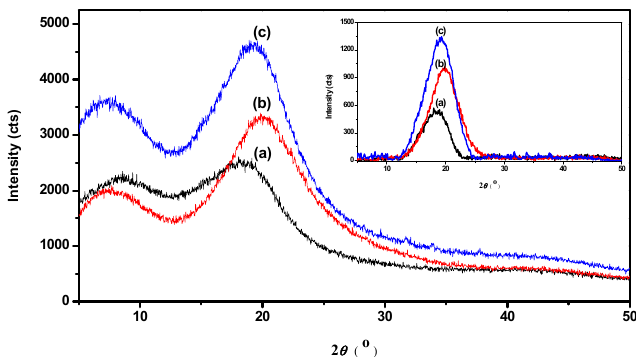
Figure 4. XRD patterns of ( a ) WPU; ( b ) WPU-H; and ( c ) SCPU. The inset shows the data by background correction.